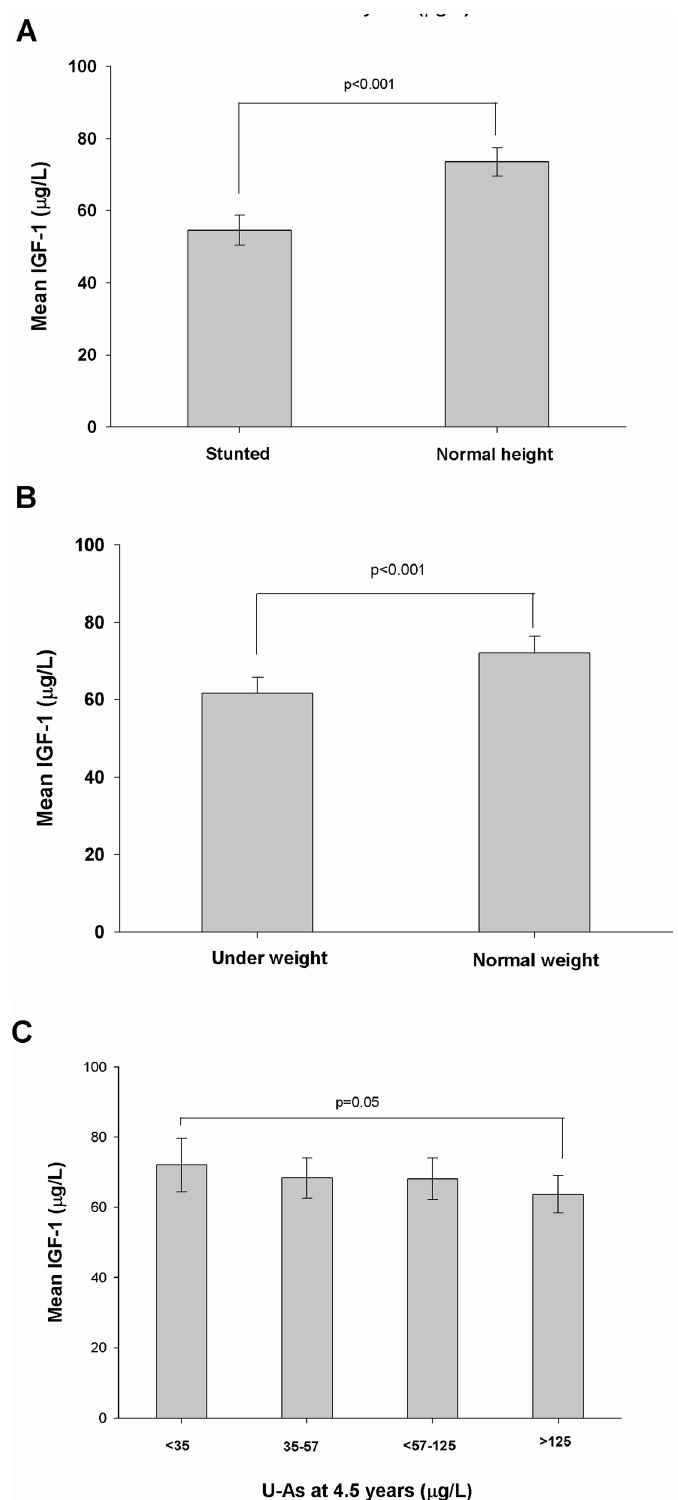
Figure 1. Mean insulin-like growth factor 1 (IGF-1) levels in (A) stunted (N=185) and normal height (N=455); (B) underweight (N=252) and normal weight (N=388). (; and (C) in different quartiles of urinary arsenic (N= 160 in each quartiles) in children at 4.5 years of age. doi: 10.1371/journal.pone.0081530.g001 PLOS ONE |